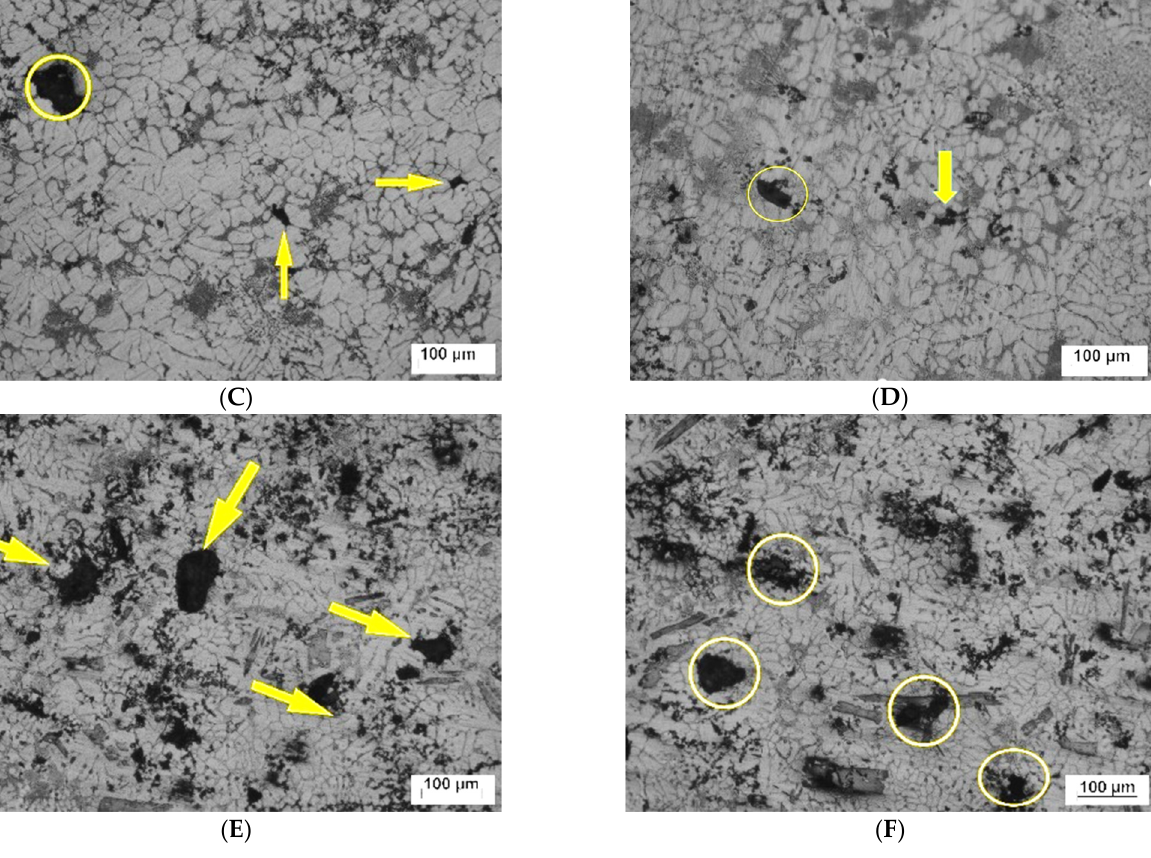
Figure 11. Optical images of Al6061/TiO 2 micro-composites ( A ) 0%, ( B ) 1wt.%, ( C ) 2wt.%, ( D ) 3wt.%, ( E ) 4wt.% and ( F ) 5wt.%, stirred at 1000 rpm for 10 min.